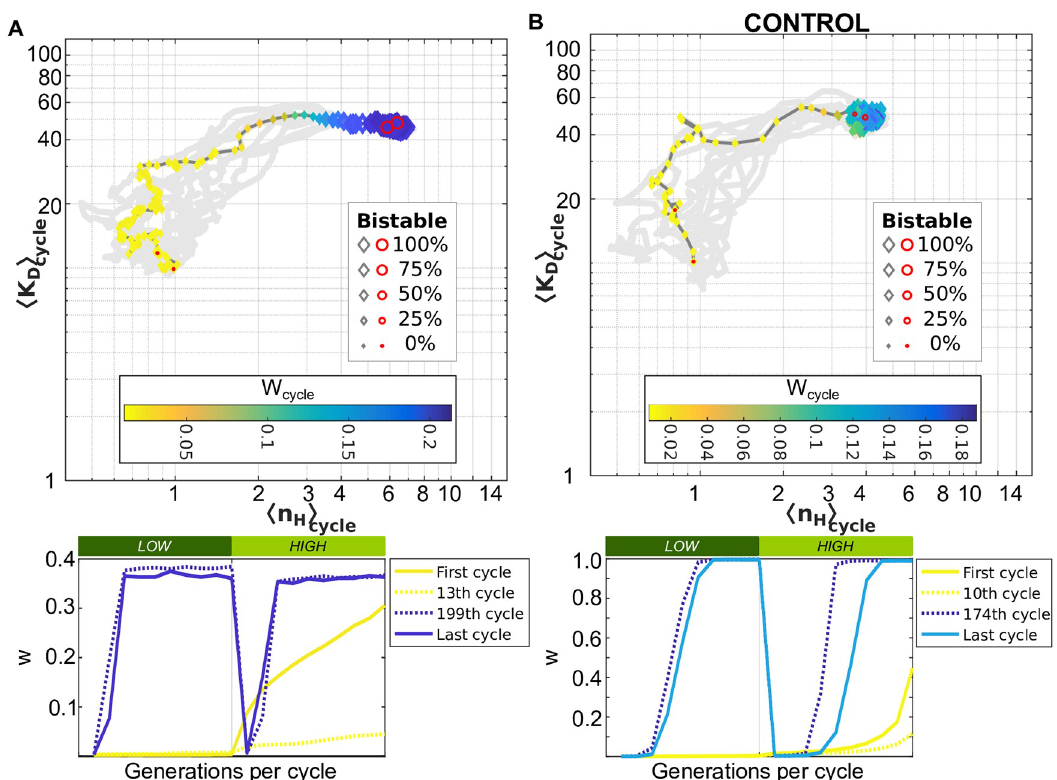
Fig 3. Evolutionary trajectory of a population adapting to a fast fluctuating environment displays selection for high nonlinearity. The initial population started from a non-optimal genotype ( θ 0 ) where k = 80, n parameters N = 10000, ν = 0.1, s t = 40, u = 0.03, and M = 1.1 both under (A) the original model and (B) in the absence of biochemical ( h K i cycle ) versus the average Hill coefficient ( h n H i cycle ) are shown for each environmental cycle noise ( CONTROL ). The average K D D simulated, colored given the geometric mean of the population fitness per environmental cycle ( W marker size corresponds to the average percentage of bistable genotypes in the population (see legend). The traces of other nine replicas are shown in gray as a reference. Each cycle spans a LOW (dark green) and HIGH (light green) epoch and there are 500 environmental cycles over 10,000 generations for each of these simulations. The population fitness w per generation for the first and last cycles, as well as the cycle with the minimum and maximum W cycle are shown in the bottom for comparison, and colored according to their W cycle value. In both simulations (A-B), the population evolved to higher nonlinearity values h n H i cycle and W cycle